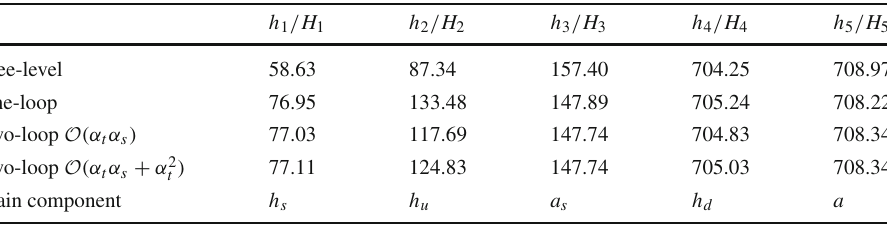
Table 8 Same as in Table 7 but using DR renormalization in the top/stop sector